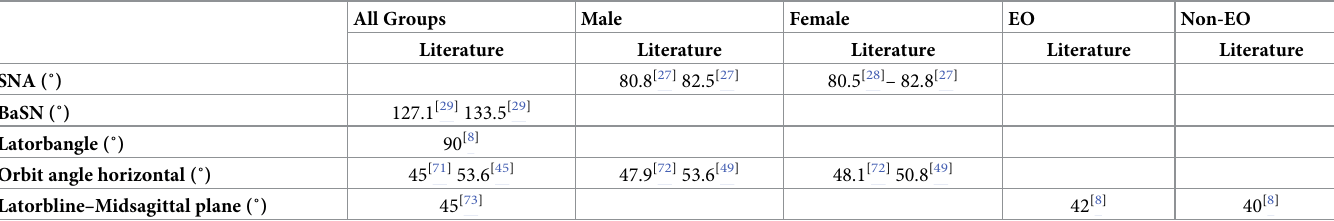
Table 8. Results for angles for comparison from previous